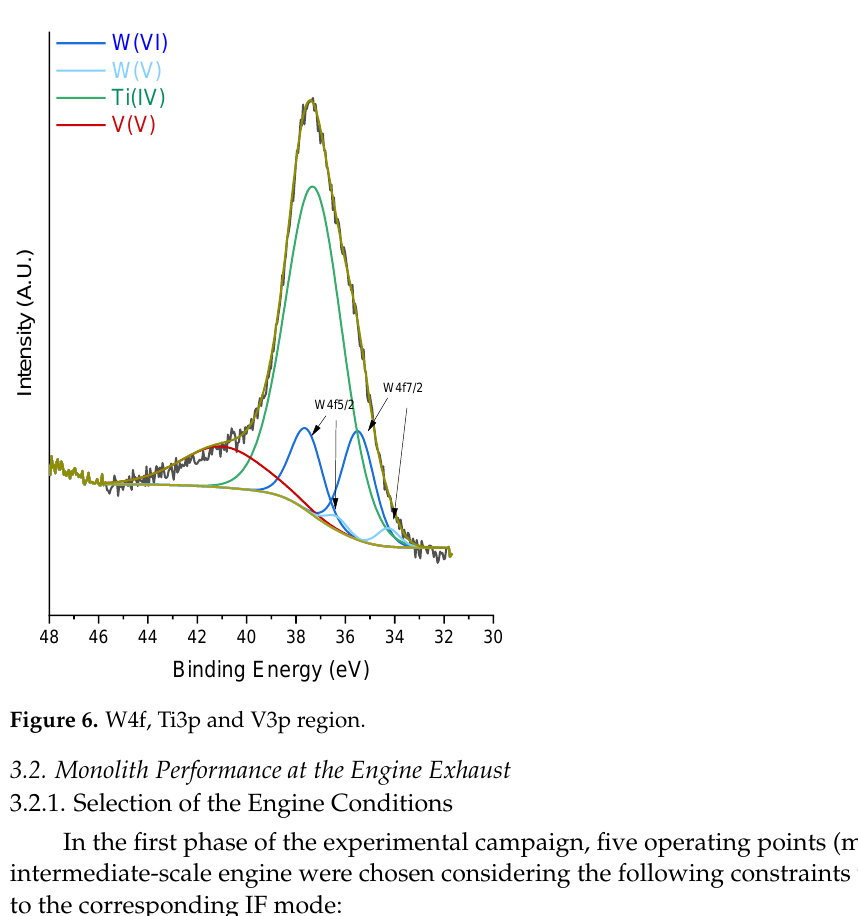
Figure 6. W4f, Ti3p and V3p region.